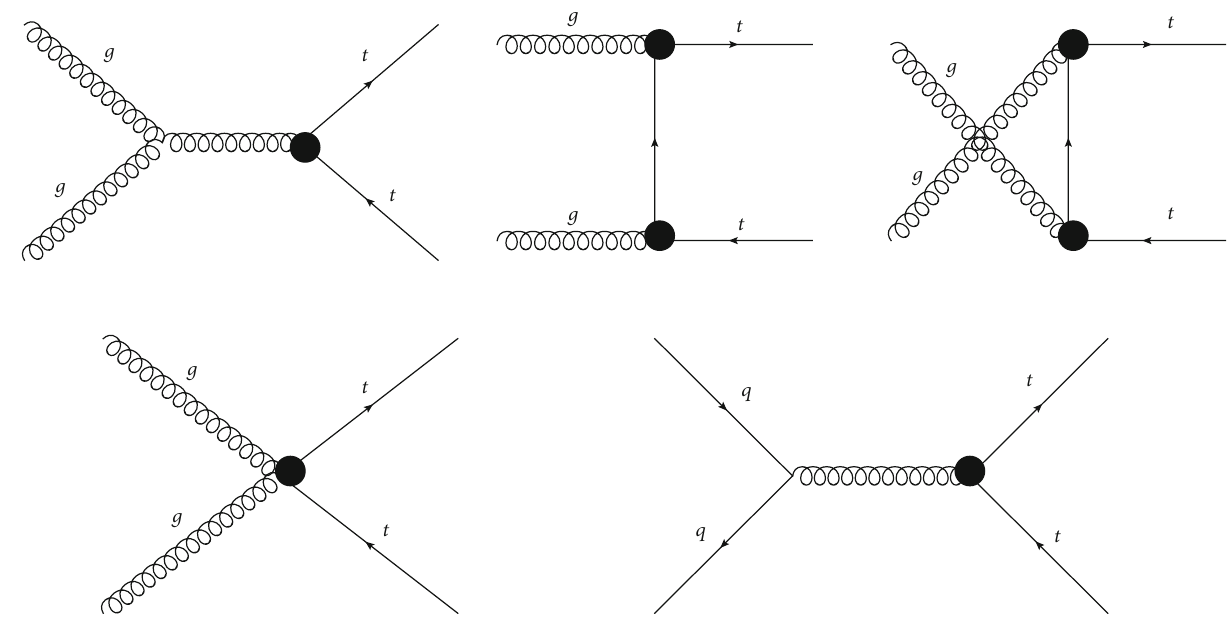
Figure 1: Feynman diagrams responsible for top-quark pair-production at the LHC.